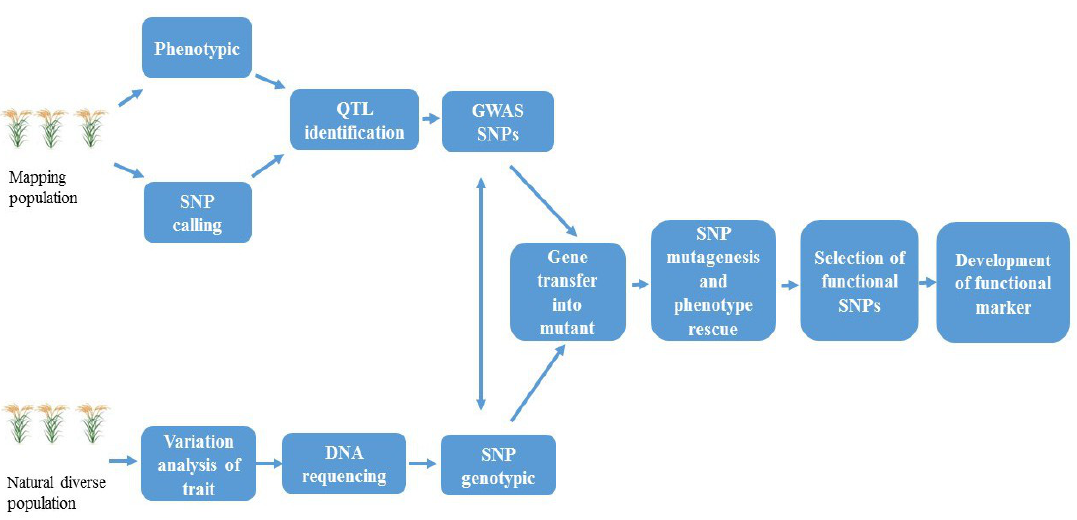
Figure 3. Genome-wide association studies (GWAS) for identification of functional single nucleotide polymorphisms (SNPs) and development of FMs.